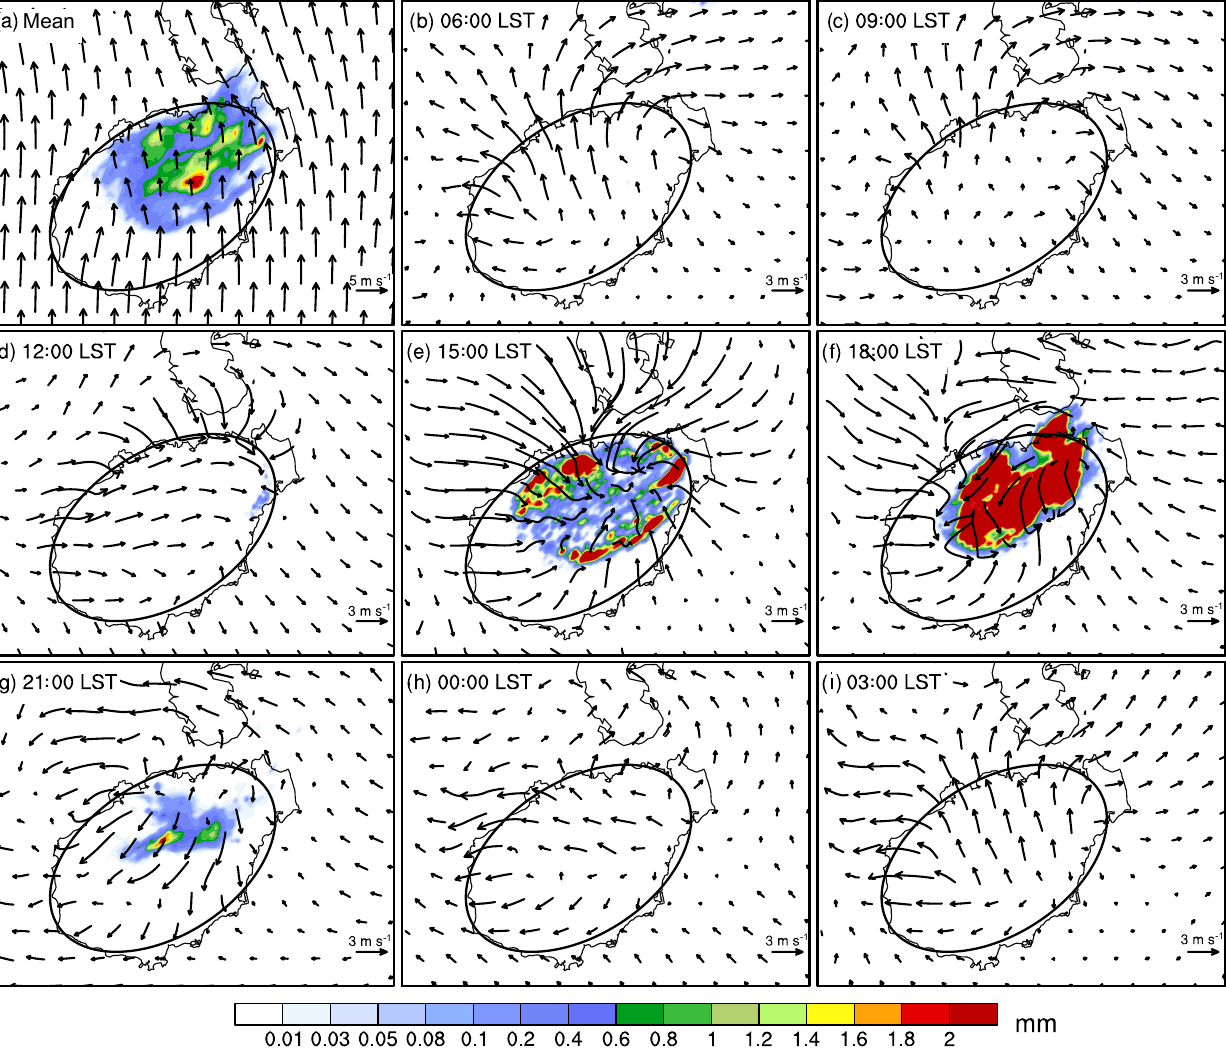
speed over the northern island than over the southern is- land, which is a result of a high negative horizontal temper- ature advection over the southern island along the coastlines (Fig. 15d). A sea-breeze front appears at the leading edge of the sea breeze along the coastline, particularly along the northernmost coast where the maximum near-surface tem- perature gradient lies (Fig. 12d). At the same time, copi- ous water vapor is transported inland from the ocean owing to the low-to-mid level prevailing wind (Fig. 11d) and up- ward motions (Fig. 14d). Clouds initially form along the sea breeze (Fig. 13c) and subsequently produce rainfall (shaded in Fig. 10d and green lines in Fig. 13d). Noticeably, more rapid warming during this period happens over the northwest of the island, while it is much slower over the other areas